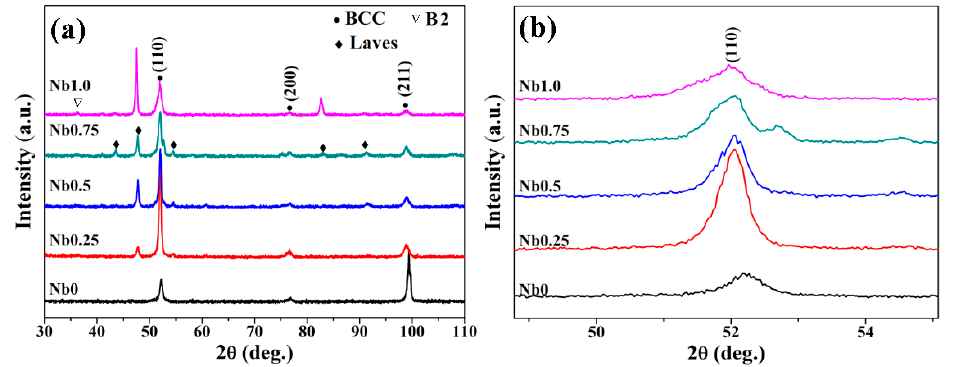
Figure 1. ( a ) X-ray diffraction (XRD) patterns of the AlCoCrFeNiNb x (x = 0, 0.25, 0.5, 0.75 and 1.0) alloy coatings. ( b ) Detailed scans for the (110) peak of the body-centered-cubic (BCC) solid solution phase. a.u. = arbitrary units; B2 = order BCC.